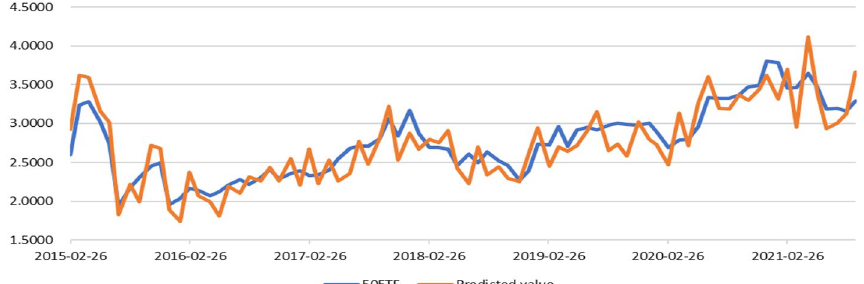
The table reflects the out-of-sample prediction results of the machine learning model and classic methods